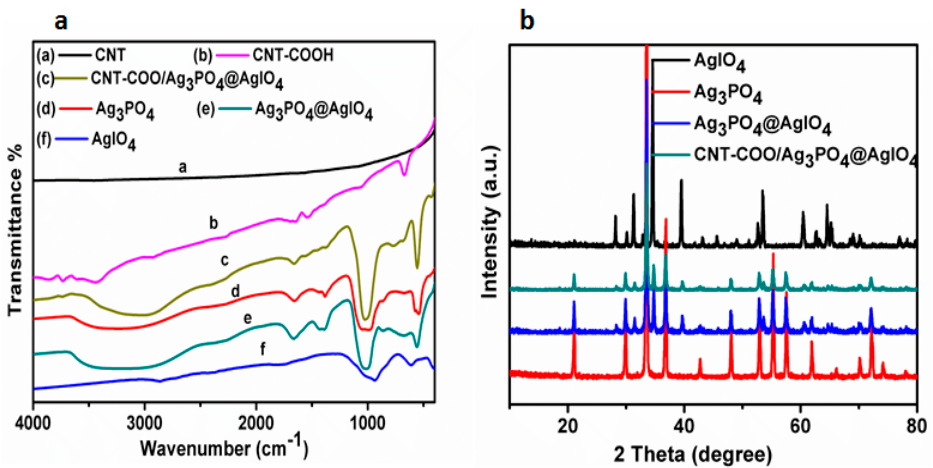
Figure 2. ( a ) The FT-IR spectra of the as-synthesized composites, ( b ) the XRD spectra of the as-synthesized.